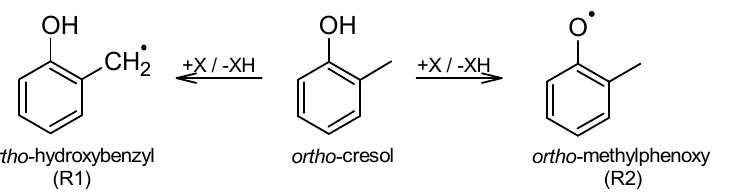
Figure 1. The structure of ortho -cresol and its most expected radicals in the low-temperature combustion domain: ortho -hydroxybenzyl ( R1 ) and ortho -methylphenoxy ( R2 ).